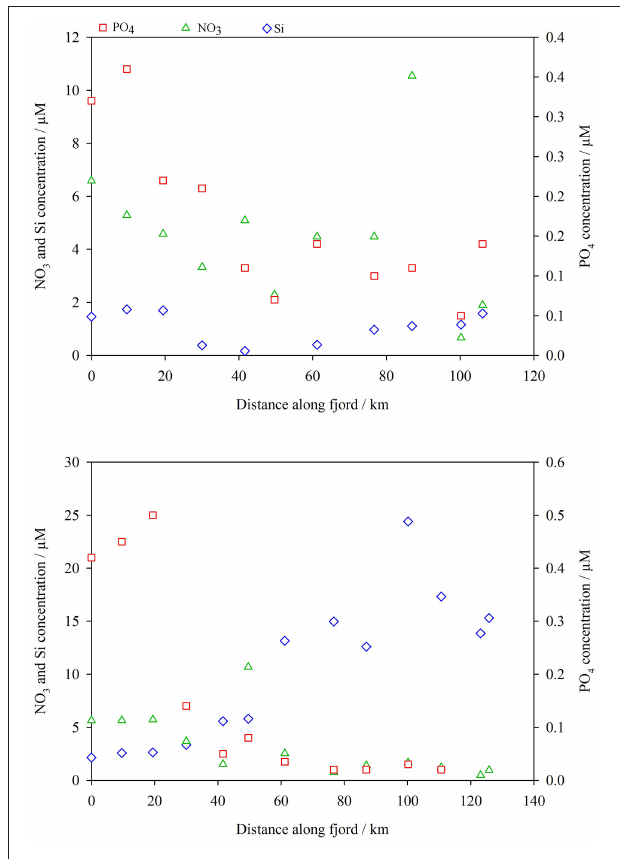
FIGURE 9 | Top: spring macronutrient concentrations at surface stations along Godthåbsfjord, May 2014 (Si blue diamonds, PO 4 red squares, NO 3 green triangles). Plotted as distance from GF2. Bottom: summer macronutrient concentrations at surface stations along Godthåbsfjord, August